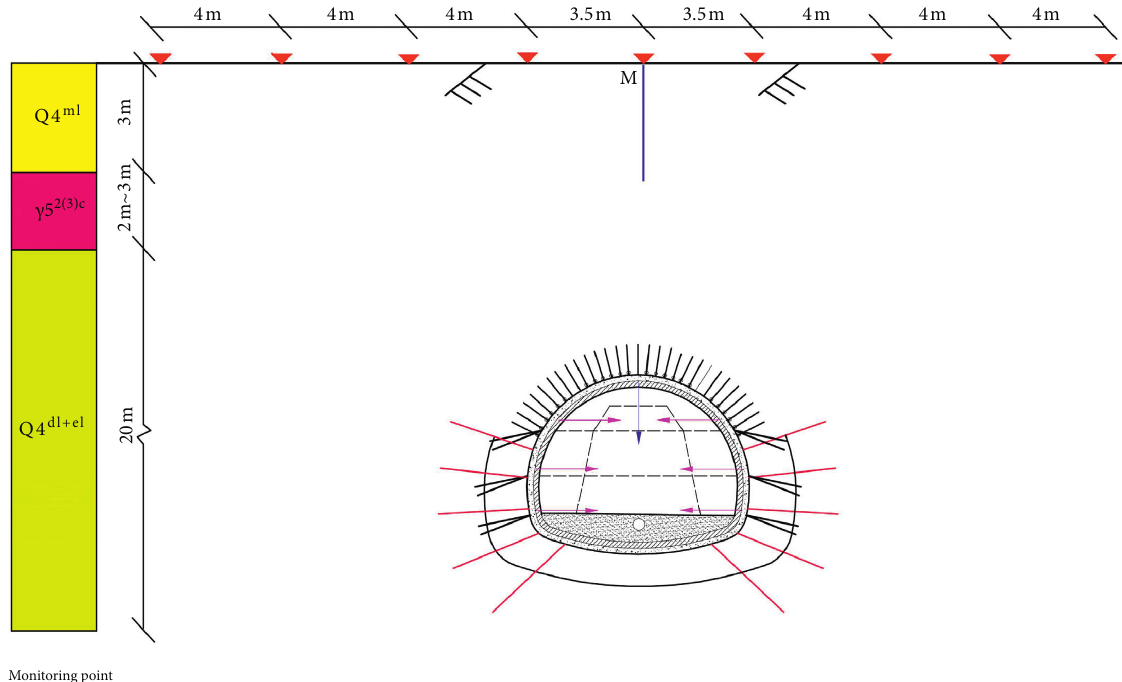
Figure 12: Layout of measuring points